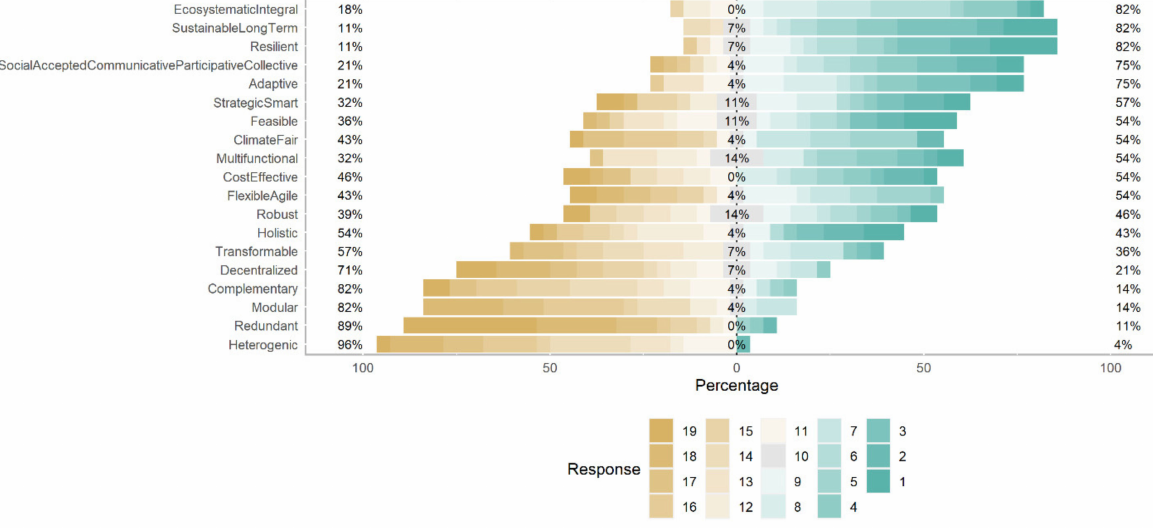
Figure A6. Percentages of Likert Scores for the important characteristics of flood management from important (1) to unimportant (19) in rural mountain